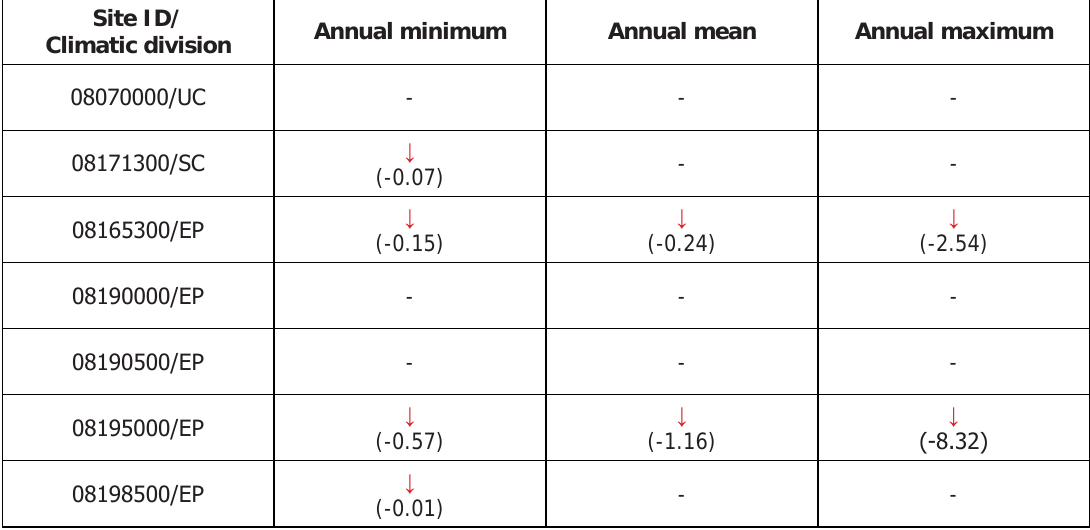
Table 4. Summary of trends in annual minimum, mean, and maximum baseflows (significance assessed at p≤0.05). Sen slope values are shown in parentheses; the units of flow are cumecs or m 3